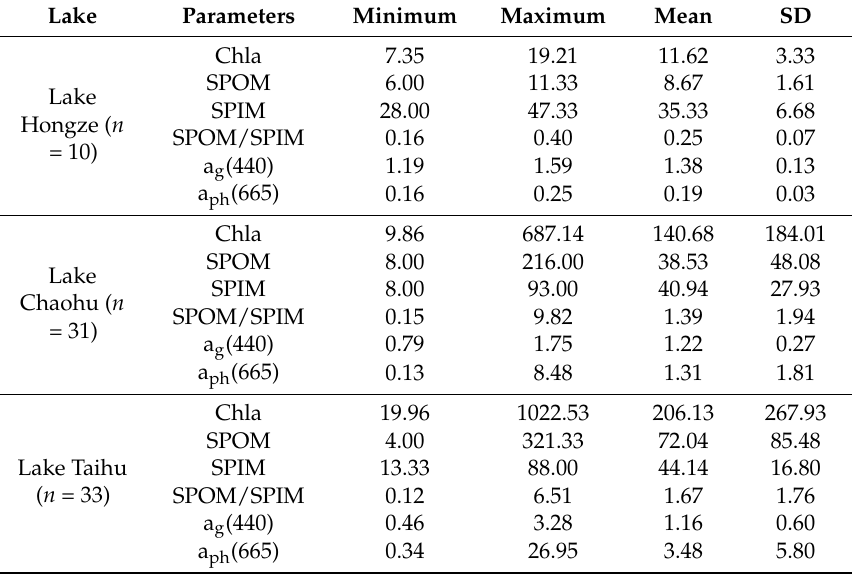
Table 3. Variations of bio-optical properties of the three study lakes (Lake Hongze, Lake Chaohu, and Lake Taihu). The unit for Chla is μ g/L. The units for SPOM and SPIM are mg/L.